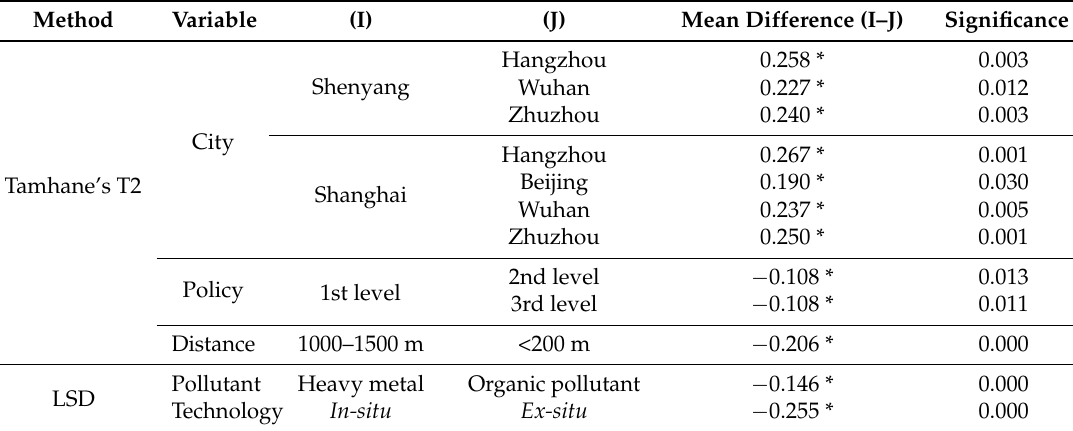
Table 9. Results of ANOVA on public